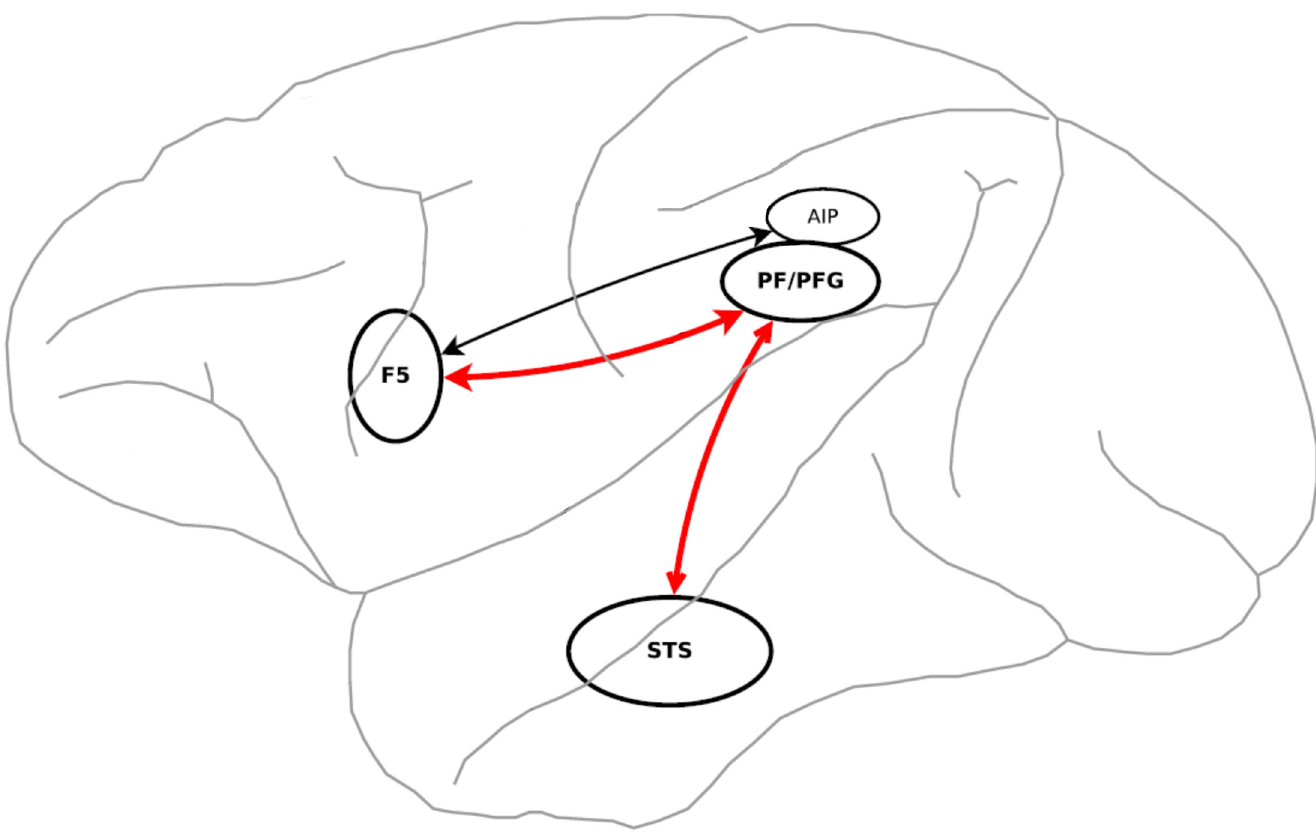
Fig 1. Schematic illustration of MNS in the macaque monkey brain. Area F5 is connected with the inferior parietal lobule (areas AIP-anterior intra- parietal, PF and PFG). Within the frontal lobe, area F5 is connected with hand/mouth representations of primary motor cortex (Source: Craighero et al.